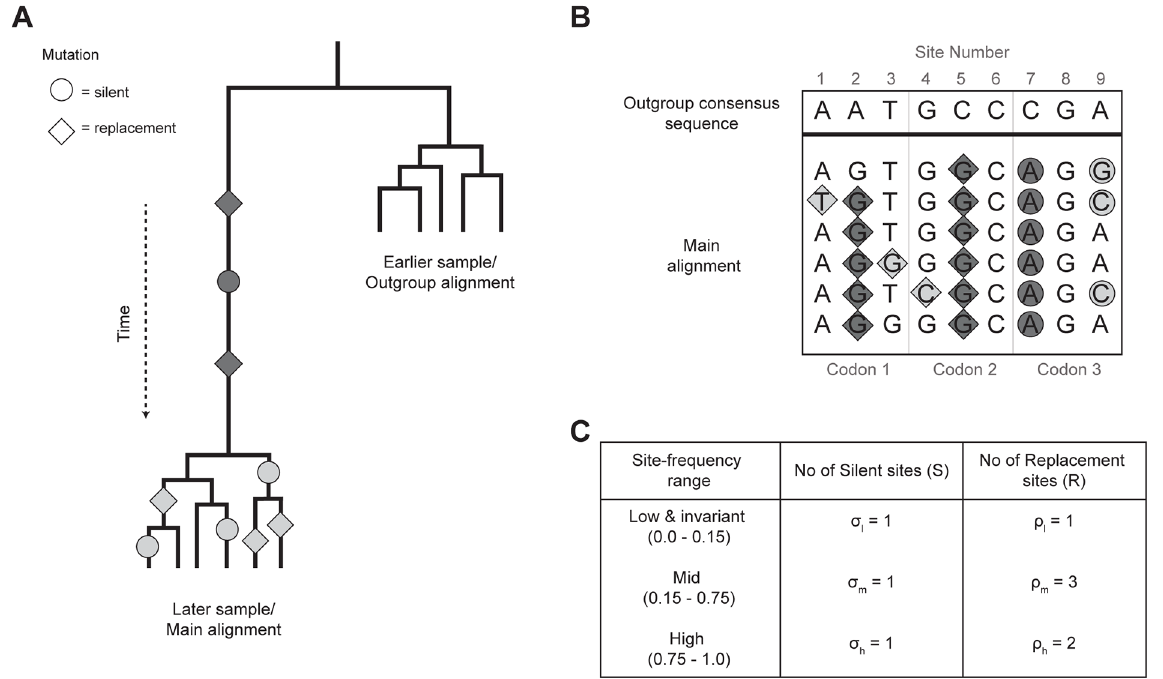
Fig 1. A schematic diagram that outlines the method used to estimate the rate of molecular adaptation in serially-sampled populations. (A) Viral sequences sampled from an earlier time point (the outgroup alignment) are compared with sequences sampled at a later time point (the main alignment). Mutations on the internal branch leading to the later sample (dark grey) represent nucleotide fixations, while all remaining mutations (light grey) correspond to polymorphisms in the later sample. Replacement (non-synonymous; diamonds) and silent (synonymous; circles) mutations are distinguished. (B) A consensus of the sequences from the earlier time point is used to identify whether fixations and polymorphisms are ancestral or derived. In this example, mutation has occurred in 7 out of 9 sites in the main alignment. (C) Nucleotide site-frequencies (i.e. the frequency of each mutation in the main alignment) are calculated and probabilistically assigned to three site-frequency ranges for both silent and replacement changes. Under neutral evolution, the ratio of replacement to silent changes in the mid site-frequency range, ρ m / σ m , is expected to equal to the corresponding ratio in the high site-frequency range ( ρ h / σ h ). Excess replacement changes in the high site-frequency range thus represent adaptive substitutions driven by positive selection (eq 2). Note that invariant sites in the alignment (i.e. sites 6 and 7 in panel B) are assigned as silent or replacement using the degeneracy of the genetic code (see S2 Table for details). Further, the site-frequency of invariant sites is probabilistically assigned using a Beta-binomial model (see Materials and